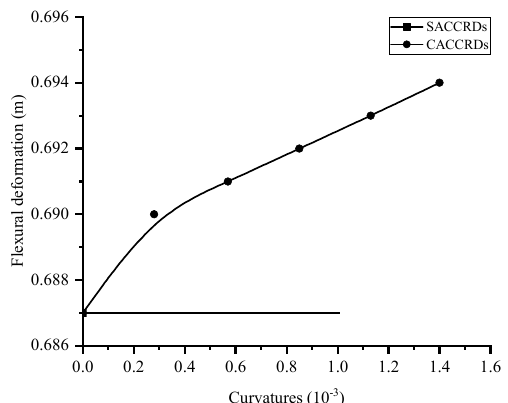
Figure 30. Relationship between flexural deformation maximum of CACC and curvature of CACC.